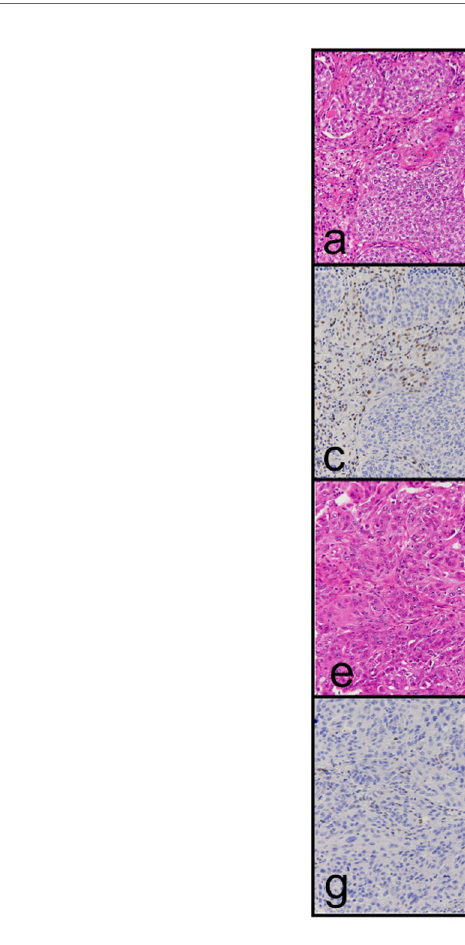
FIGURE 1 | Representative images of hematoxylin andeosin staining (A,E) andimmunohistochemical staining of hMLH1 (B, F) andhPMS2 (C,G) inMMR de fi ciency lung carcinoma. Loss of hMLH1 andhPMS2 expression can beobserved.In addition,p40 protein expression can beobserved (D,H) . Case 1 is (A) to (D) ; case2 is (E) to (H)